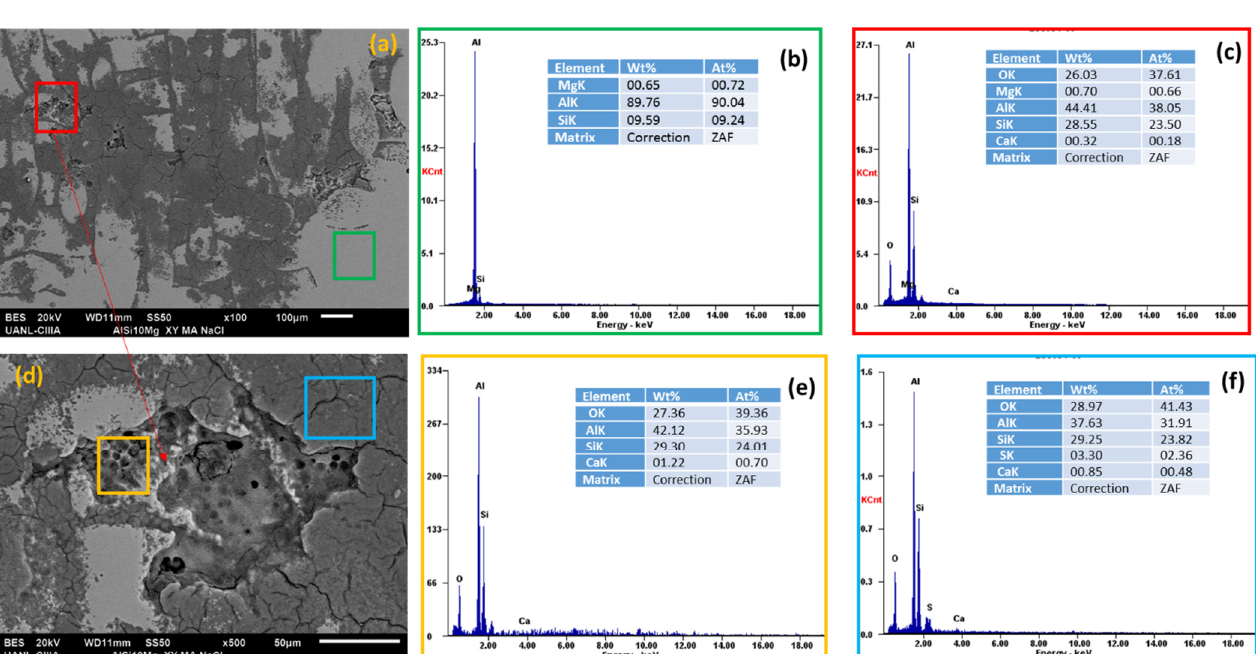
Figure 20. SEM-EDS surface morphology micrographs of Al-A.M. ( a ) alloys in H 2 O solution and EDS spectrum analysis: ( b ) green box and ( c ) blue box.